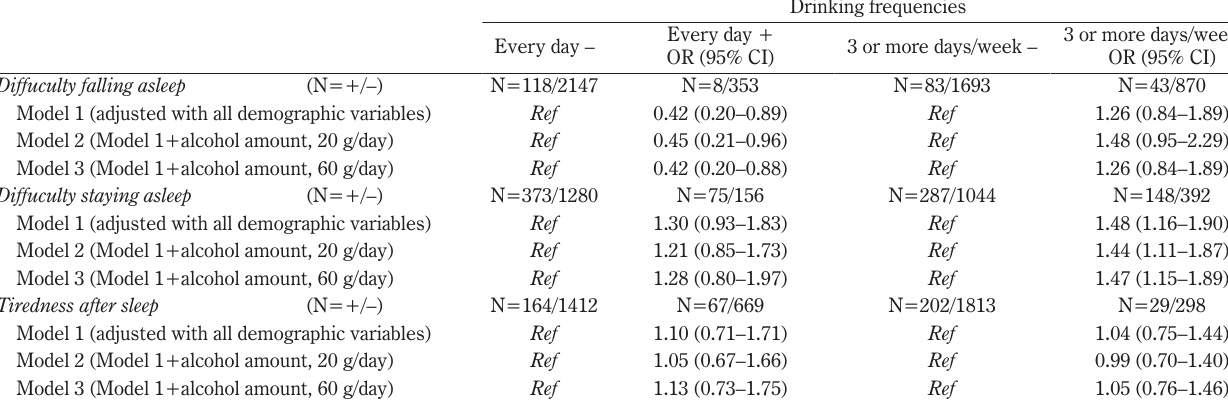
Table 2 Longitudinal association between persistent drinking frequency and insomnia symptoms